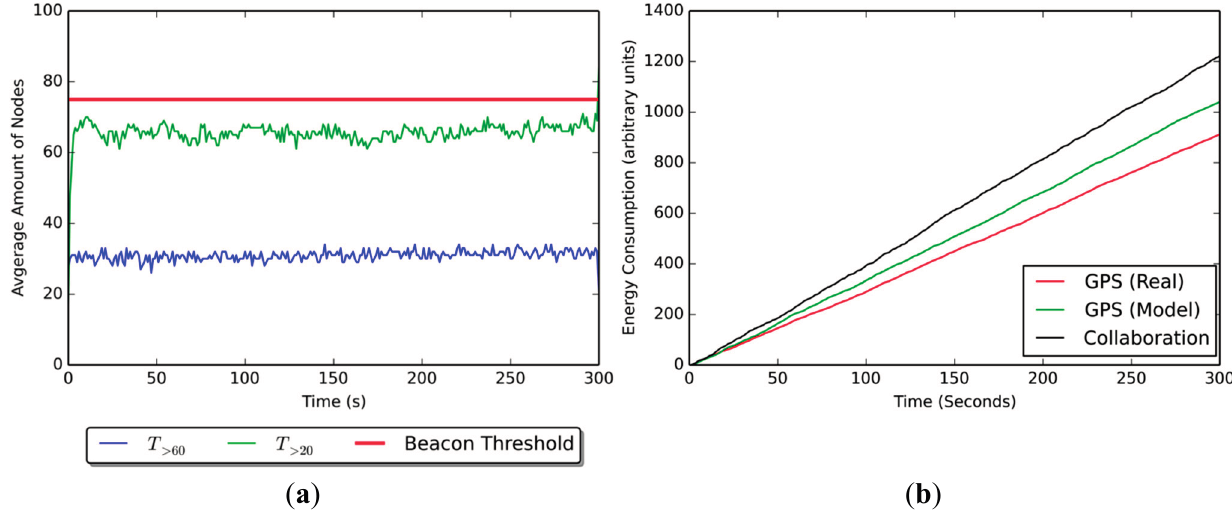
Figure 7. ( a ) Average node count and ( b ) average energy consumption for the